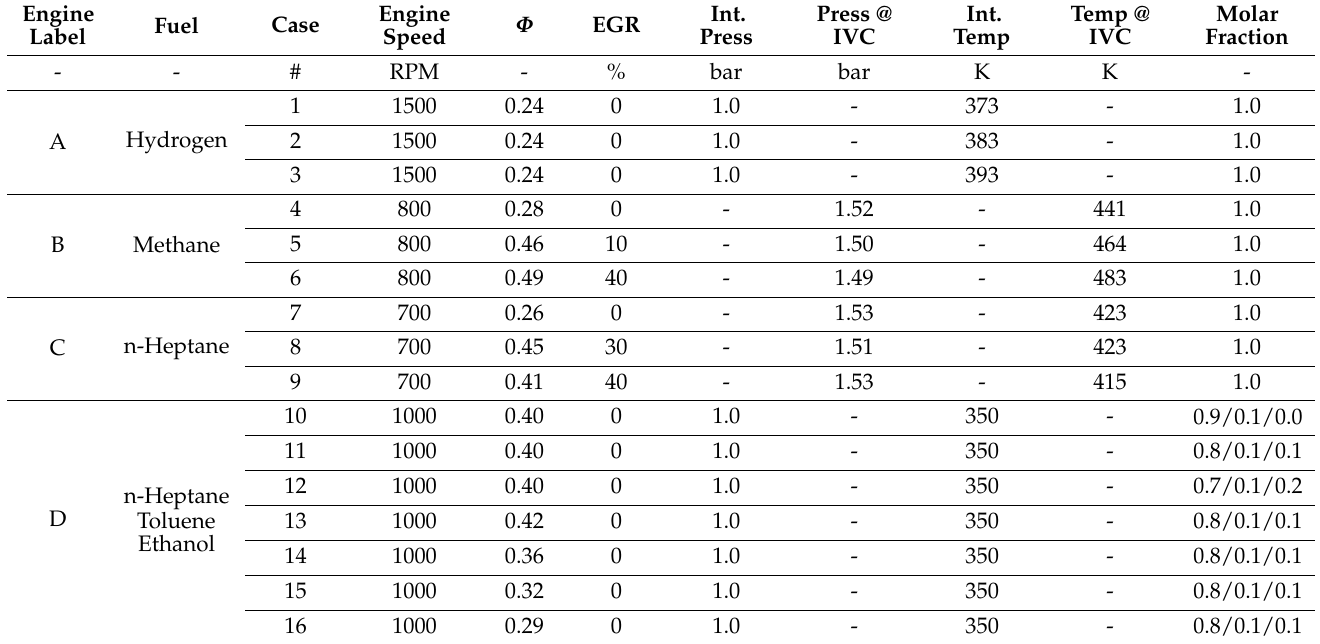
Table 3. Operating conditions of the tested